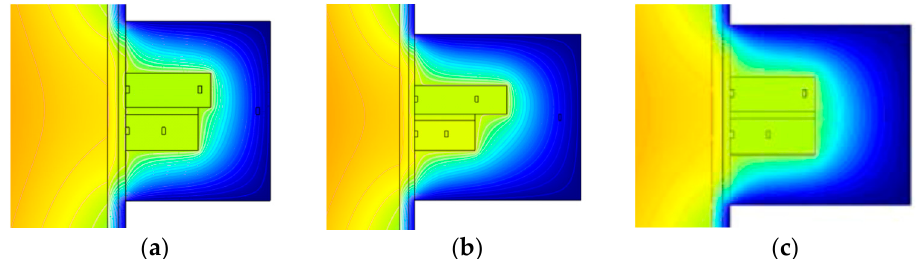
Figure 5. Distribution of temperature fields in the tissue and the transducer. ( a ) Transducer structure version when (L 1 + L 2 ) < (L 5 + L 6 ); ( b ) Transducer structure version when (L 1 + L 2 ) (cid:28) (L 5 + L 6 ); ( c ) Transducer structure version when (L 1 + L 2 ) = (L 5 + L 6 ) and L 3 is higher than in versions ( a , b ).